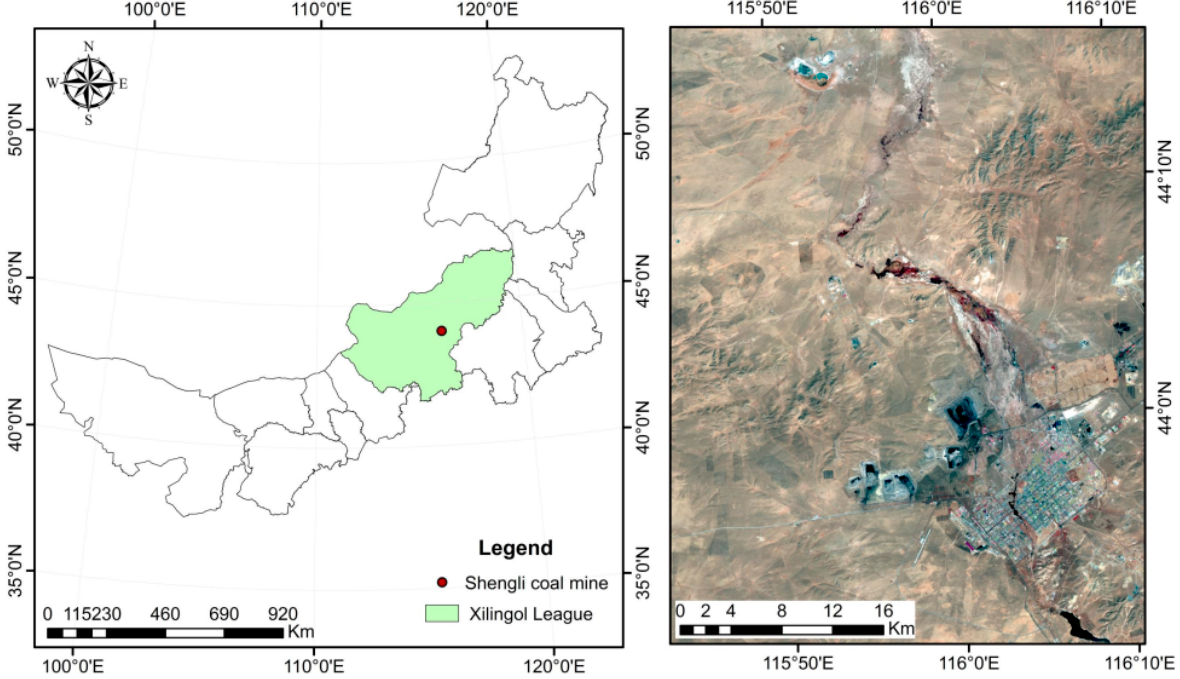
Figure 1. Image of the Shengli opencast coal mine in Xilingol League, Inner Mongolia of China.